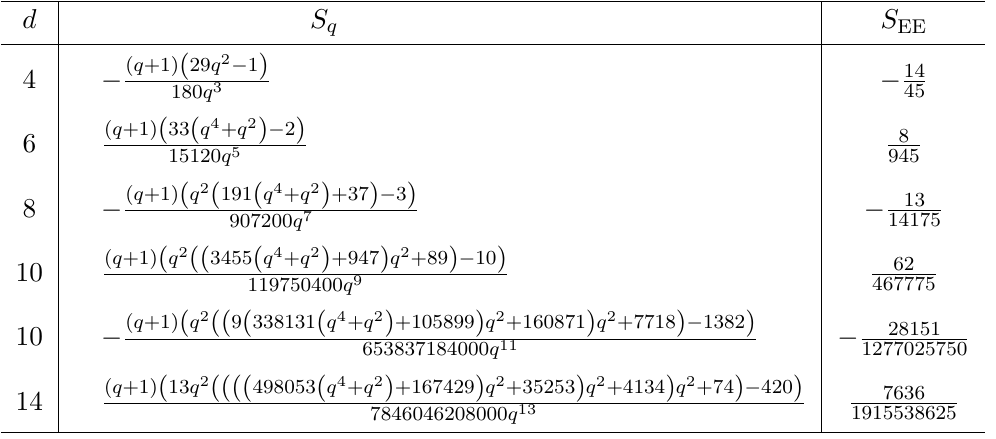
Table 2 . Universal terms in Rényi entropies and entanglement entropies of four-derivative Weyl- covariant